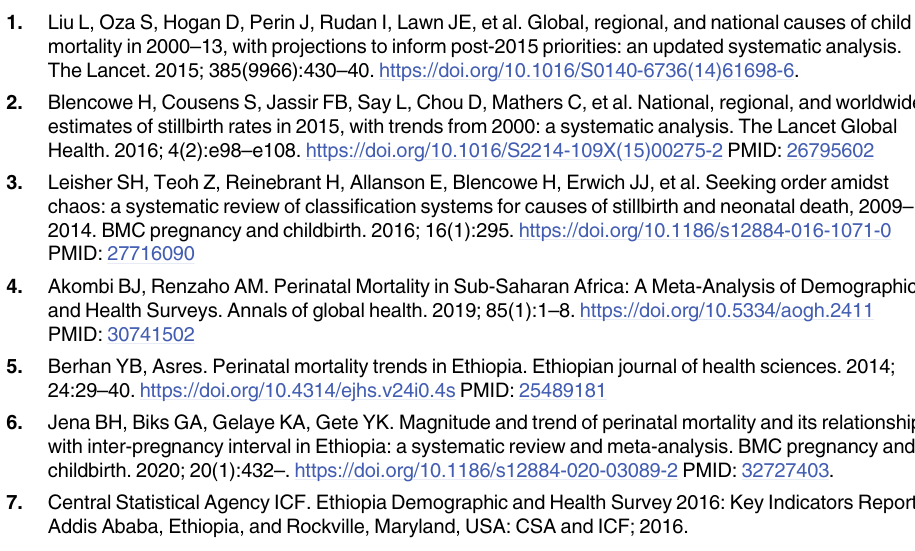
S3 Table. Searching using CINAHL. S4 Table. Assessment of risk of bias for individual study